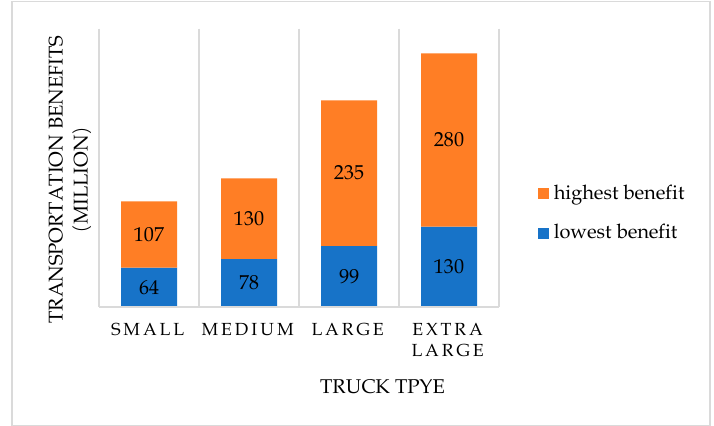
Figure 11. 15 Years of transportation cost-effectiveness for truck drivers.